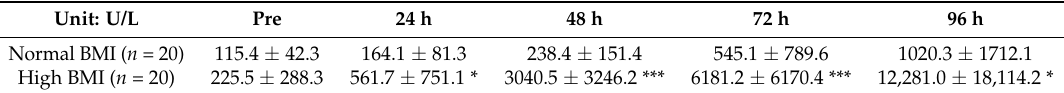
Table 4. Changes in the creatine kinase level according to the body mass index after eccentric exercise. Unit: U/L Pre 24 h 48 h 72 h 96 h Normal BMI ( n =